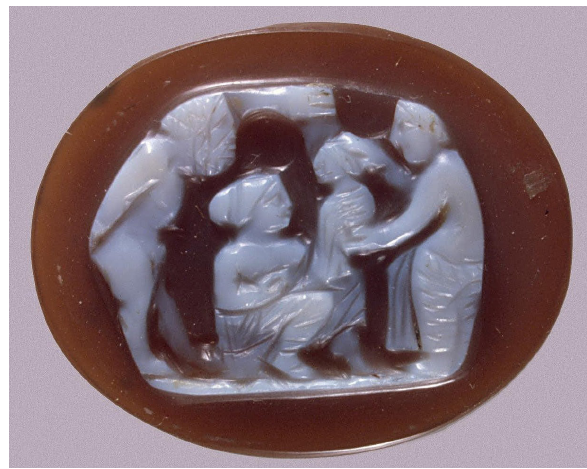
Figure 13. Roman Cameo, 3rd century CE, childhood of Bacchus. From https://hermitagemuseum.org/ Animals rescuing, breastfeeding, or rearing babies or children is another form of “alternative